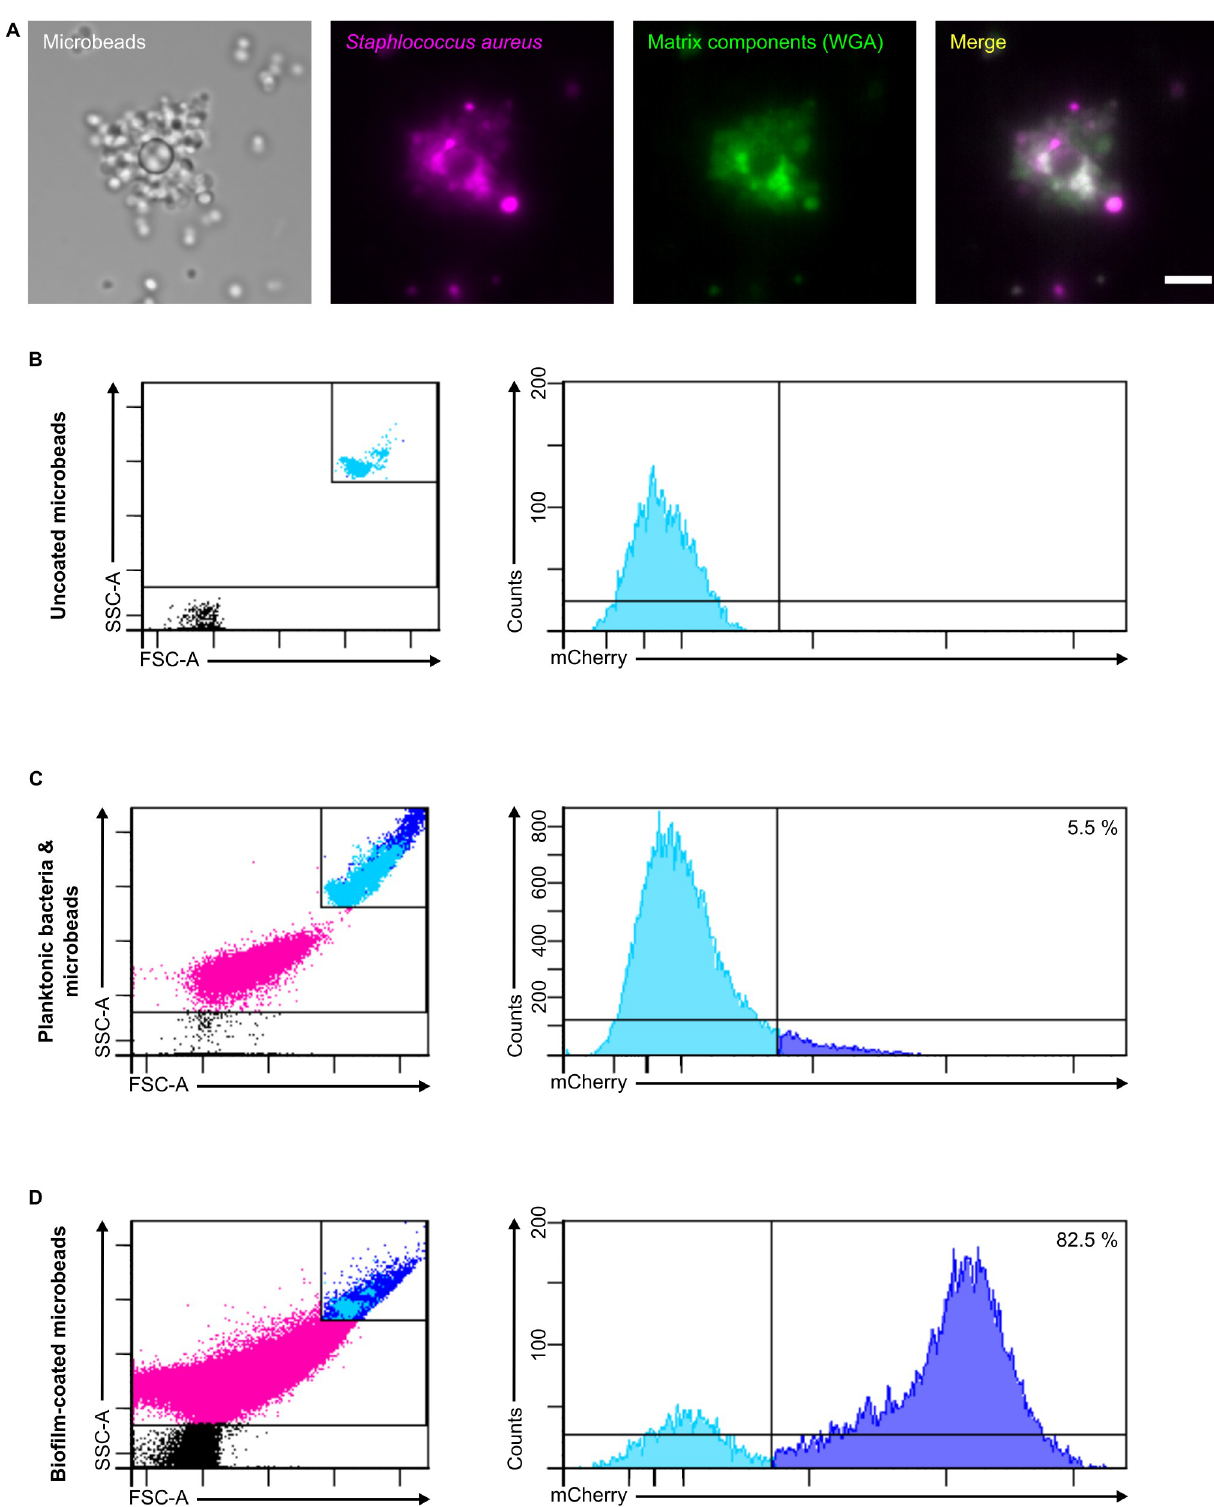
Fig 2. Confocal images of a biofilm-coated microbead and representative flow cytometry plots verifying coating of microbeads. Confocal images (A) of biofilm-coated microbeads, after passing through the micro-injection needle, treated with Alexa Fluor 488 WGA at X63 magnification. Images show microbeads and maximum intensity projections of mCherry (magenta) and Alexa Fluor 488 WGA (green) fluorescence. The merged image shows maximum intensity projections for both fluorescence channels. Scale bar: 5 μ m. Representative FACS plots showing the gates used to determine uncoated